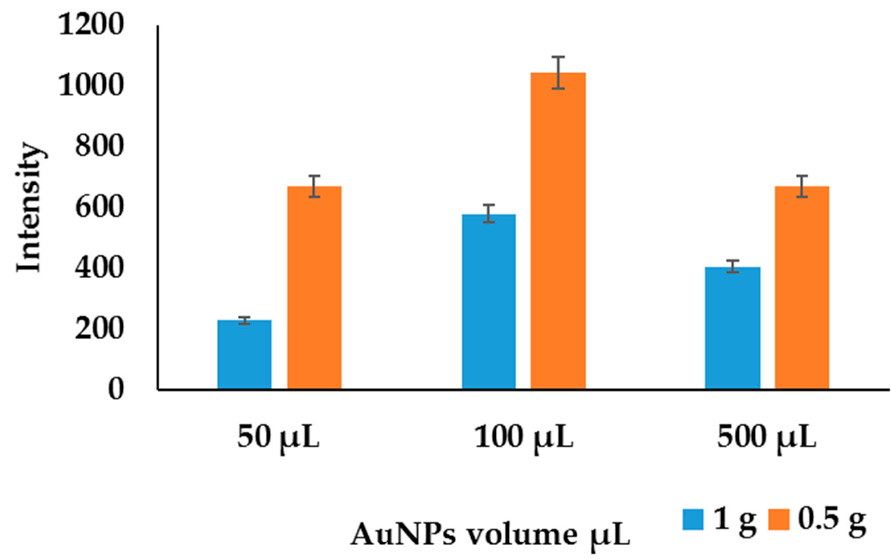
Figure 9. Effects of AuNPs’ volume spiked in different masses of soil.